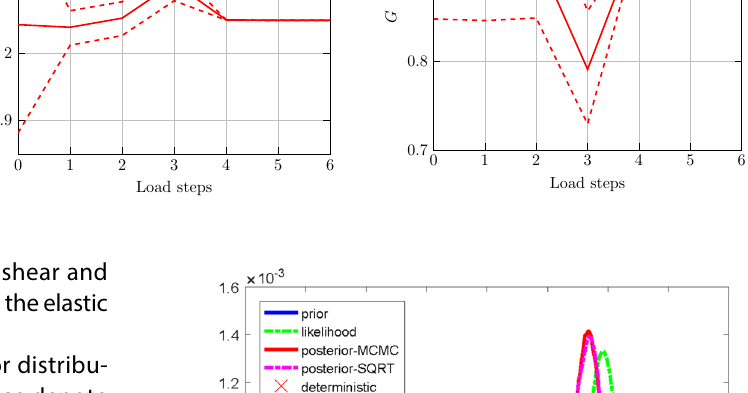
Fig. 7 Homogenized elastic properties. Left: identification of the bulk modulus. Right: identification of the shear modulus